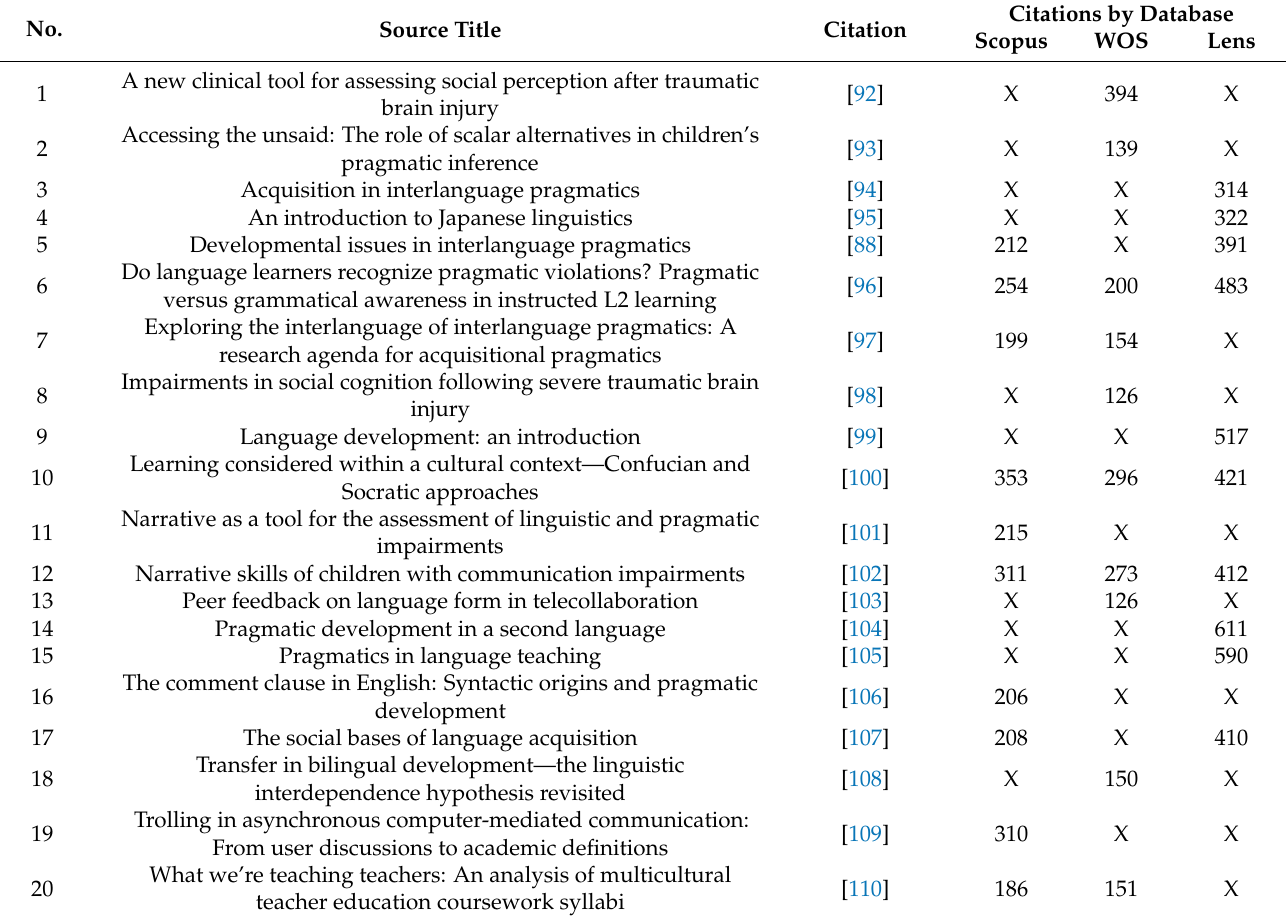
Table 5. Top cited documents in pragmatic language development from Scopus, WOS, and Lens.